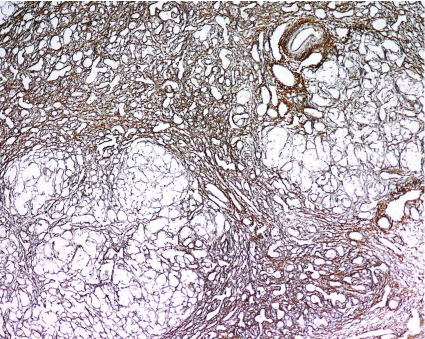
Figure 2: Hepatectomy specimen, postnatal age 30 days. Nodu- larity is apparent. The relatively stroma-poor nodules consisted of hepatocellular parenchyma, sometimes cholestatic. The intervening regions that exhibit more compact connective-tissue elements were sites of hepatocellular loss and stromal collapse, with neocholangi- olar transformation of remaining parenchyma. Reticulin, original magnification